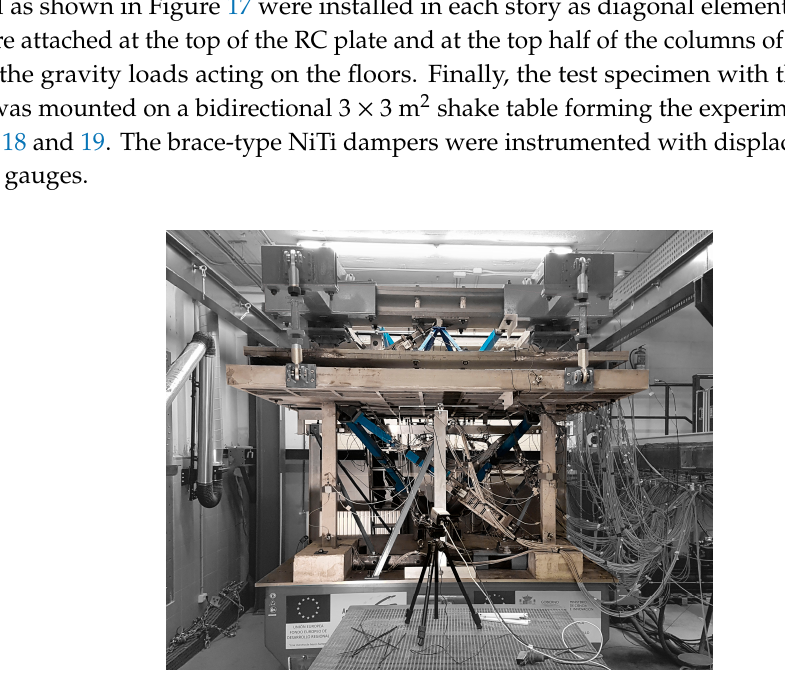
Figure 18. Overall view of the experimental set up for the shake table tests.